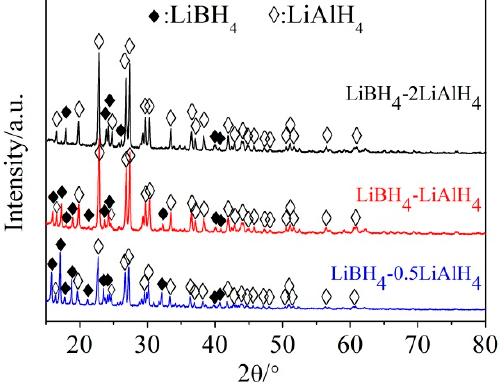
Figure 2. XRD patterns of the as-prepared LiBH 4 / x LiAlH 4 ( x = 0.5, 1, 2) composites.